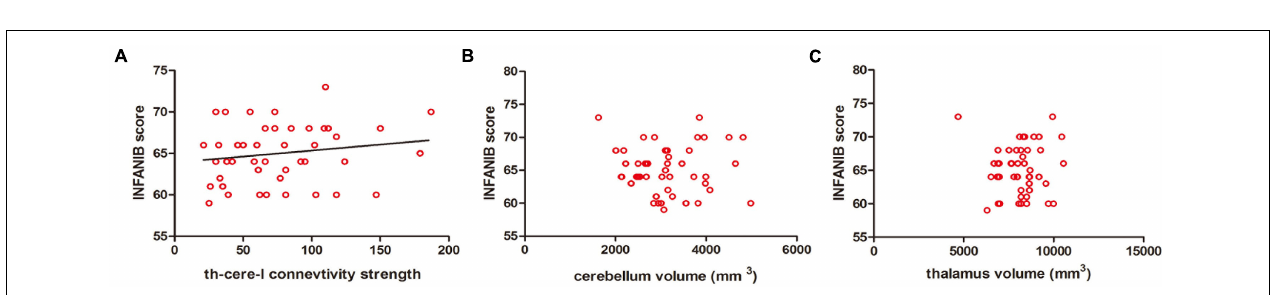
FIGURE 4 | The motor scores accessed by Peabody Developmental Motor Scales, second edition (PDMS-2) after iron supplementation at corrected age of 6 months old. (A–C) Although the mean of total motor quotient was slightly lower in A-LF group rather than NA-HF group, there was no significant difference in total motor quotients, gross motor quotients, and fine motor quotients between A-LF and NA-HF groups at this age.